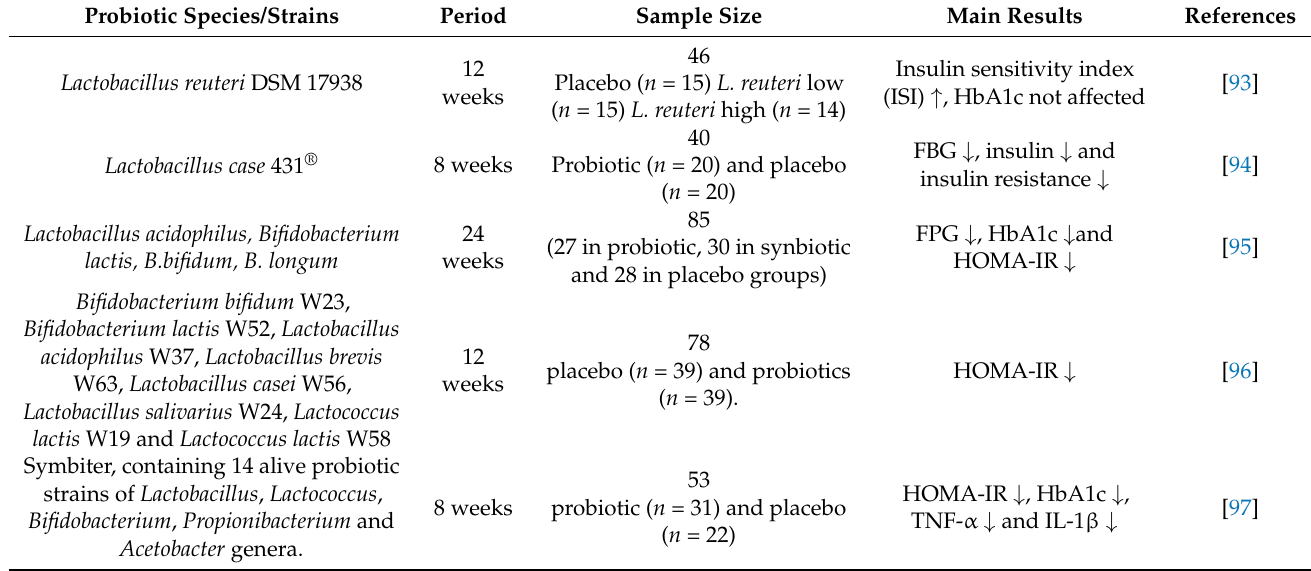
Table 3. Probiotics RCT intervention in patients with